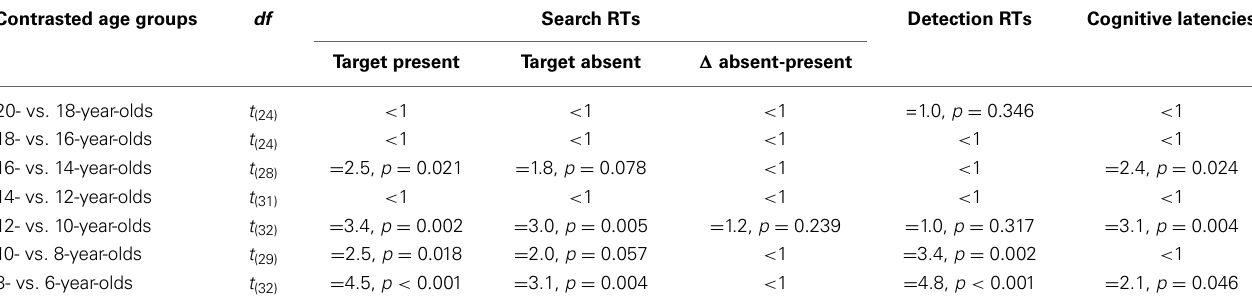
Table 1 | Statistical t -test